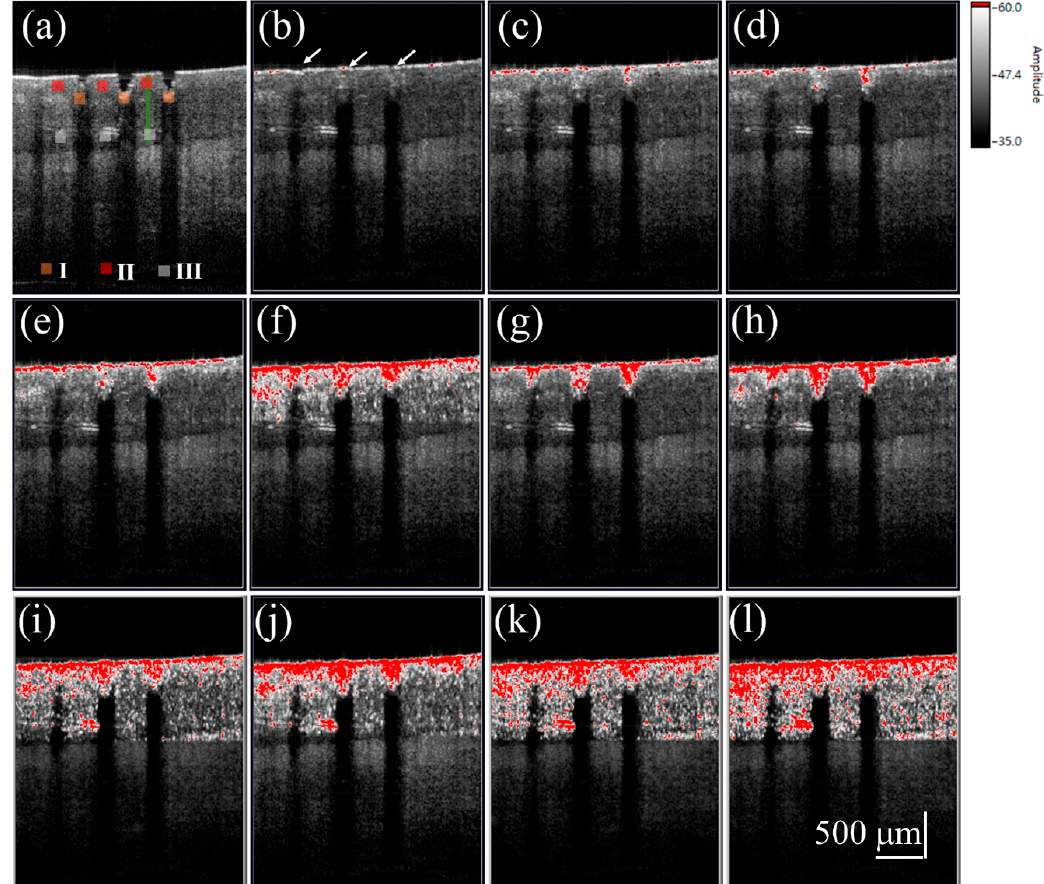
Figure 5. ( a ) 2D OCT image of the nail after fractional laser exposure with an exposure energy of 50 mJ. Time-series SV-OCT images of the nail obtained at ( b ) 0 s; ( c ) 0.2 s; ( d ) 0.4 s; ( e ) 0.6 s; ( f ) 0.8 s; ( g ) 1.0 s; ( h ) 2.0 s; ( i ) 4.0 s; ( j ) 6.0 s; ( k ) 8.0 s; and ( l ) 10.0 s after the cream drug application. The white arrows indicate that the MAZs were filled with the cream drug. The scalar bar in ( l ) represents a length of 500 µ m.